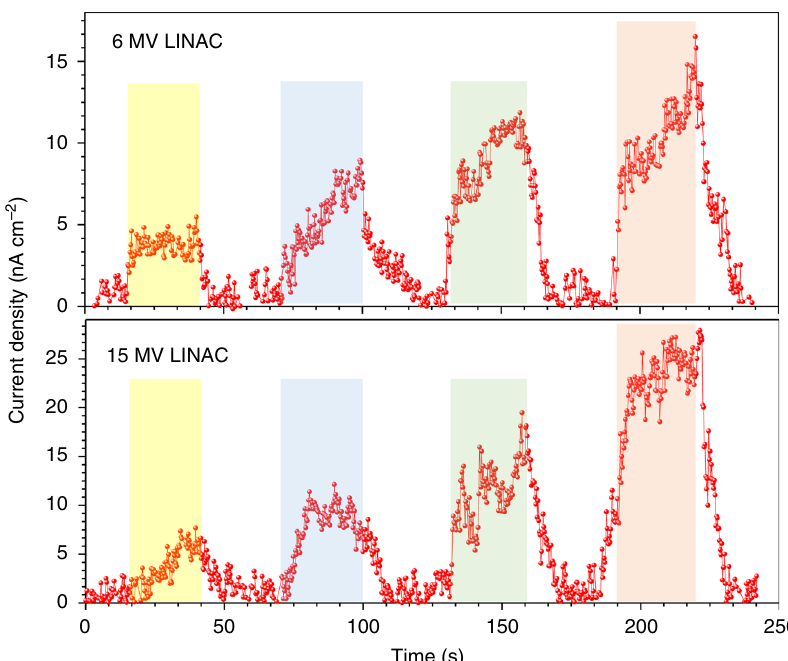
Fig. 3 Hard X-ray irradiation. Response of a Bi 2 O 3 -40 device under linear accelerator (LINAC) generated 6 and 15 MV X-rays, the consecutive peaks represent the response to dose rates of 114, 227, 340 and 454 µ Gy s −